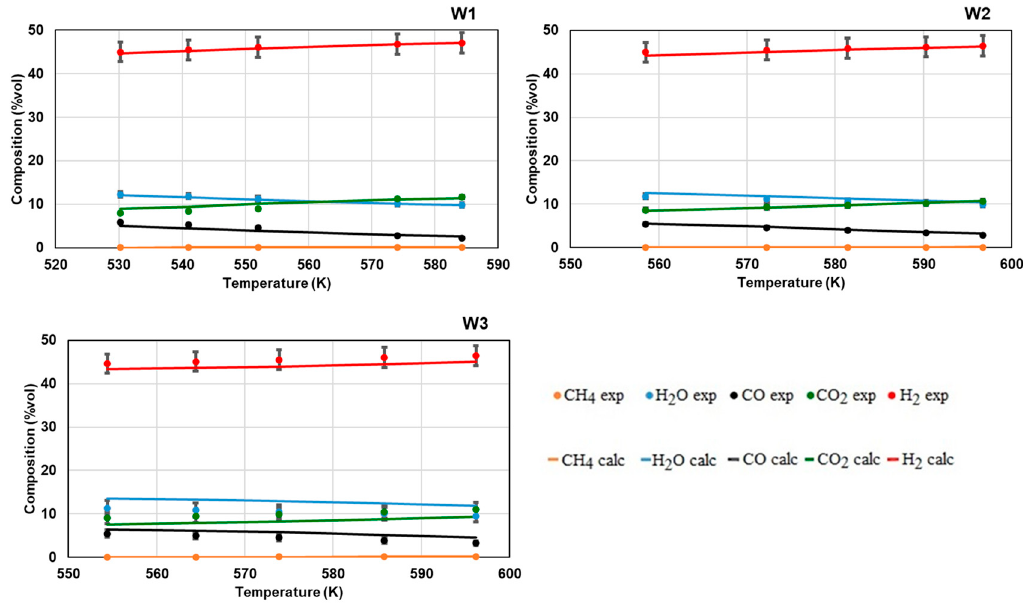
Figure 6. Comparison of the experimental results and the kinetic model results for the three catalytic systems, in the condition H 2 O/CO = 14/7. Table 3. Structured catalyst